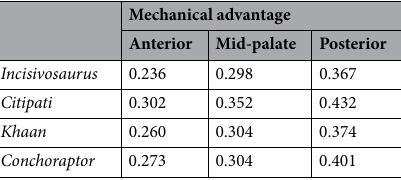
Table 3. Mechanical advantage values for the three different positions of the bite force estimates.